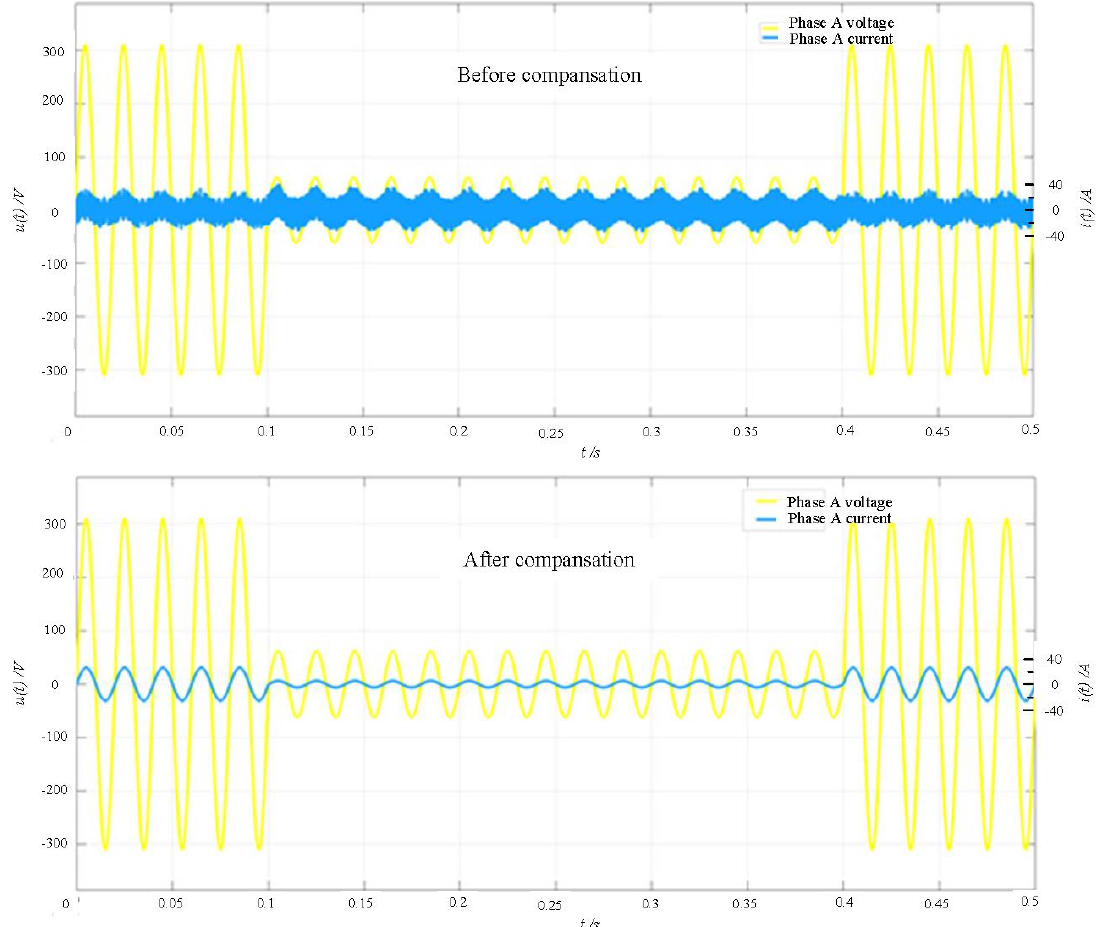
Figure 7 . Reactive compensation during LVRT . Figure 7. Reactive compensation during